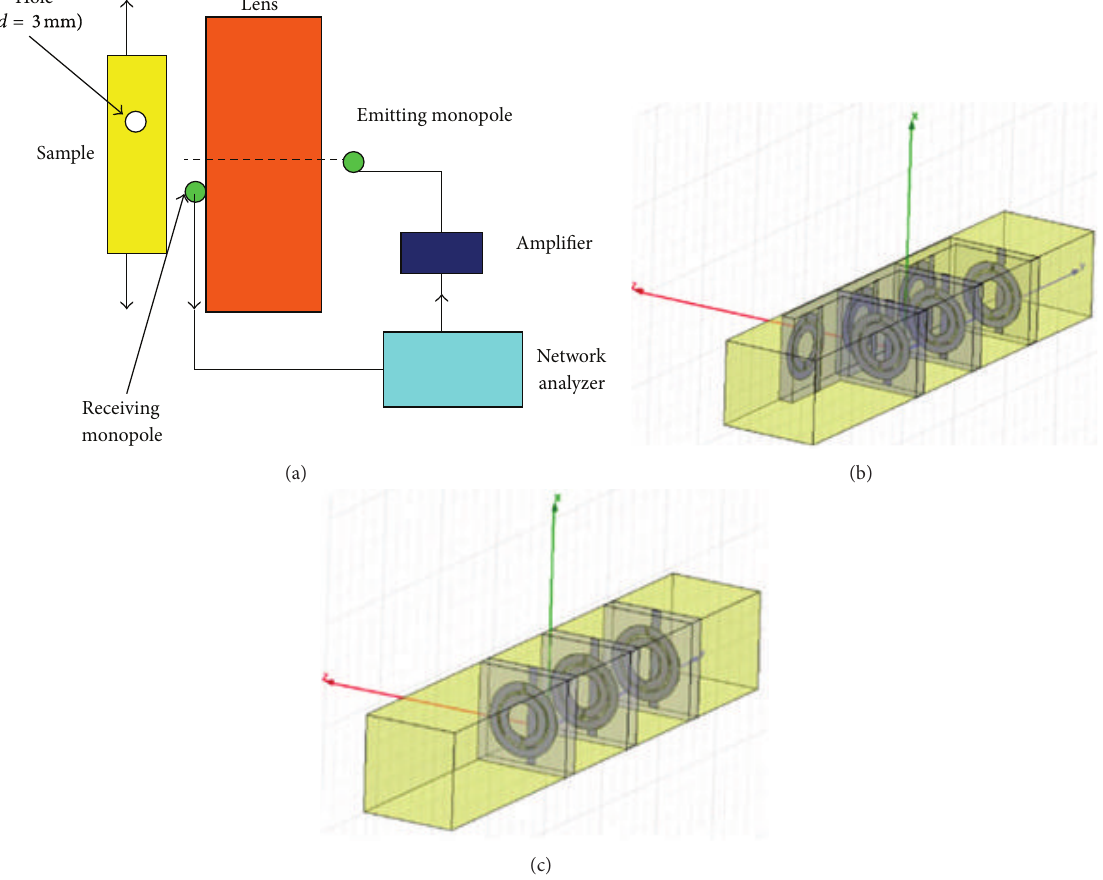
Figure 13: (a) Sketch of the nondestructive evaluation sensor system. (b) 2D unit cell models. (c) 1D unit cell models [57]. 1D and 2D lenses. The 1D lens yielded a focus spot size of 0.7 𝜆